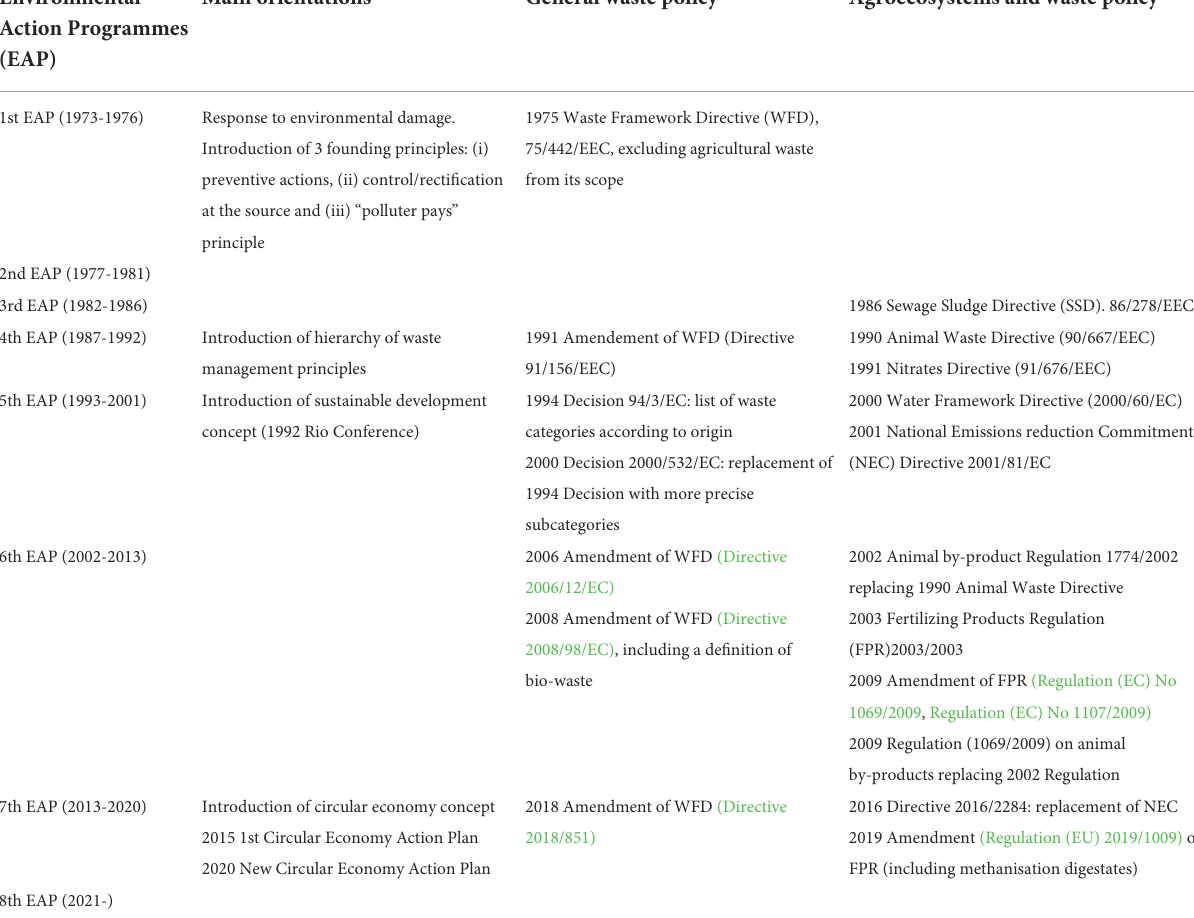
TABLE 1 Timeline of European Union’s 50 years of environmental policymaking on waste in general and on waste and by-products in agroecosystems.